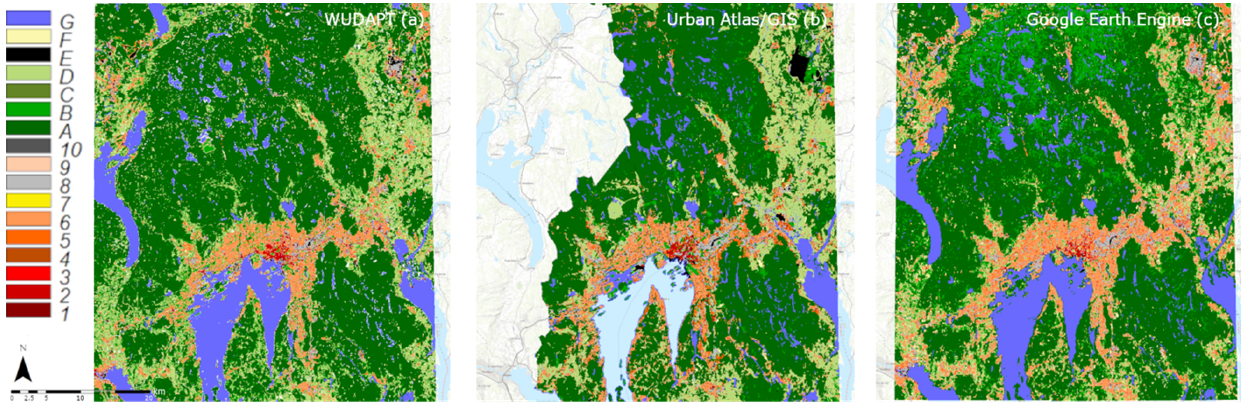
Figure 12. The LCZs resulting from the three methods: WUDAPT ( a ), UA/GIS ( b ), and Google Earth Engine ( c ), with the LCZ type classification in the legend on the left. For a full description of LCZ typologies 1–10 and A–G, please see Figure S1 in the Supplementary Materials.